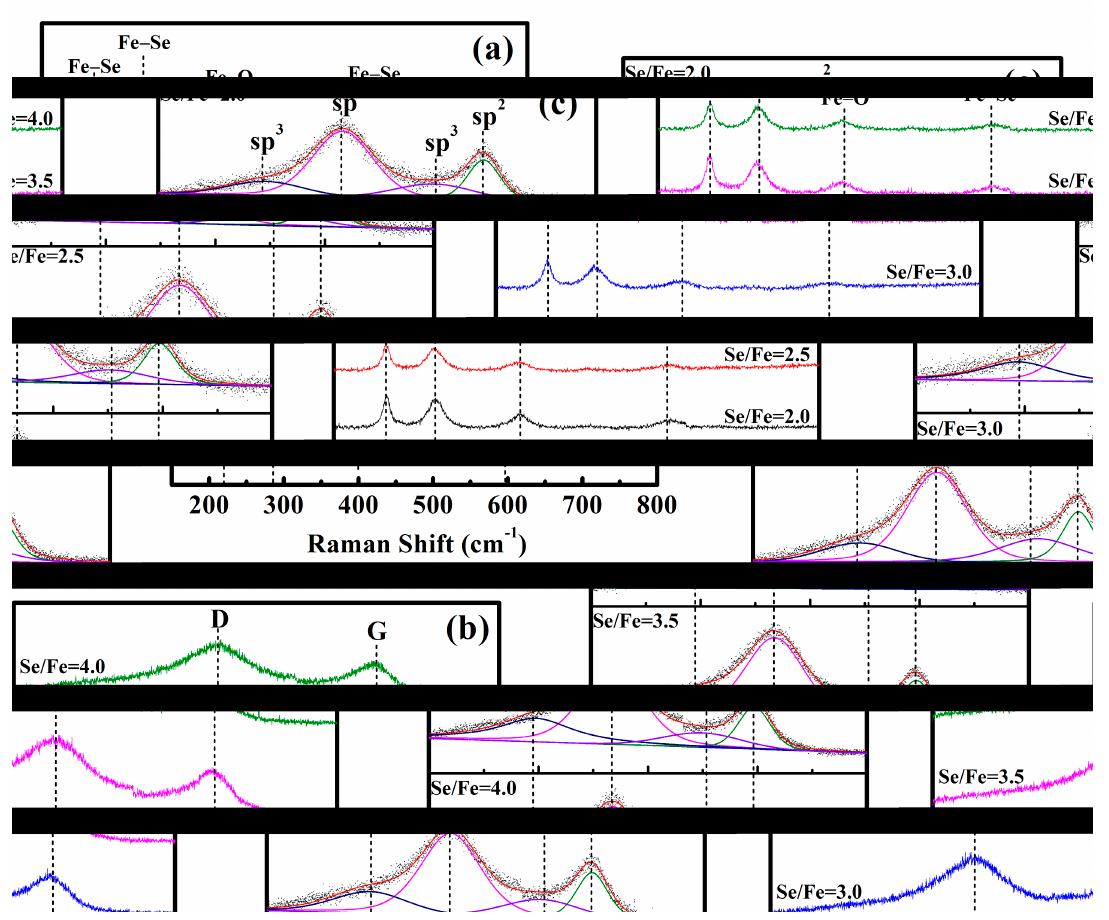
Figure 5. ( a , b ) Raman spectra of FeSe 2 /C prepared with different Se/Fe ratios; ( c ) Fitting curves for Raman spectra ( b